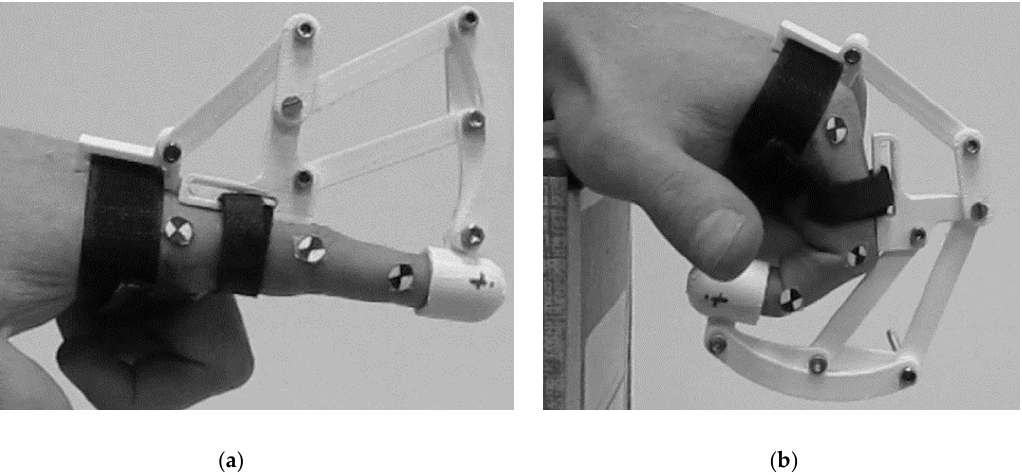
Figure 2. Desired motion assistance for a finger that moves from fully open ( a ) to fully closed ( b ).